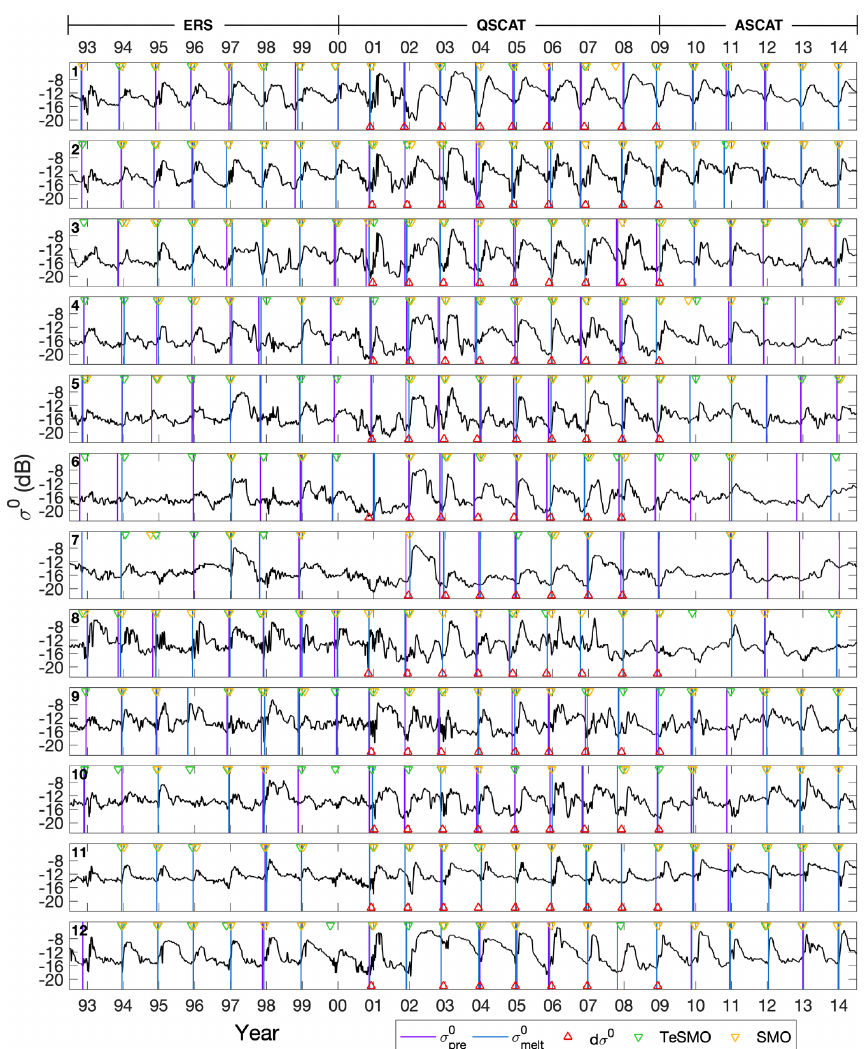
Figure 2. Time series of 6d mean backscatter coefficients ( σ 0 ) from 1992/1993 to 2014/2015 averaged over the respective nine pixels at the study locations on perennial sea ice (Fig. 1, 1–12). Purple and blue lines show the scatterometer-derived snow pre-melt ( σ 0 pre ) and melt ) onset dates when the algorithm criteria were met (Sect. 2.2.1). Red triangles indicate the snowmelt onset retrieved from diurnal ( σ 0 melt backscatter variations (d σ 0 ) of QSCAT data. Green and yellow triangles show the Temporary Snowmelt Onset (TeSMO) and Continuous Snowmelt Onset (SMO) derived from passive microwave observations from Arndt et al.